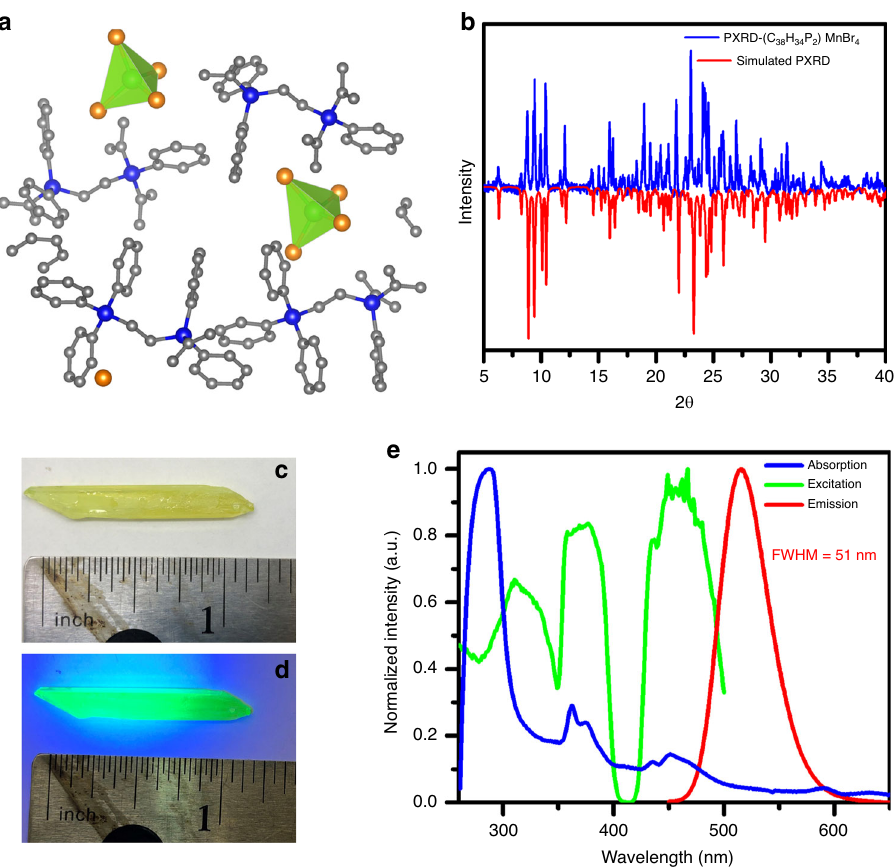
Fig. 1 Structural and photophysical characterization of (C 38 H 34 P 2 )MnBr 4 single crystals. a View of the single-crystal structure of (C 38 H 34 P 2 )MnBr 4 (Mn green, Br orange, P blue, C gray; hydrogen atoms were hidden for clarity). b PXRD patterns of (C 38 H 34 P 2 )MnBr 4 and the corresponding simulated peaks from the single-crystal structure. The images of a (C 38 H 34 P 2 )MnBr 4 single crystal under daylight ( c ) and UV light ( d ). e Absorption, excitation, and emission spectra of (C 38 H 34 P 2 )MnBr 4